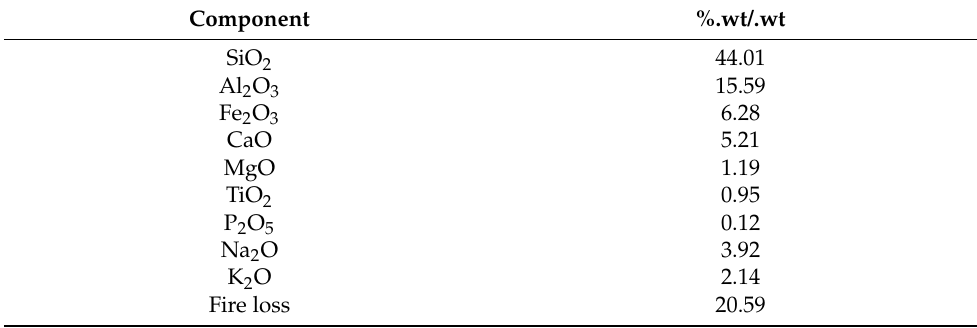
Table 3. Composition of chemically Si–Al ash pellets used as the catalyst for catalytic upgrading experiments, obtained via XRF